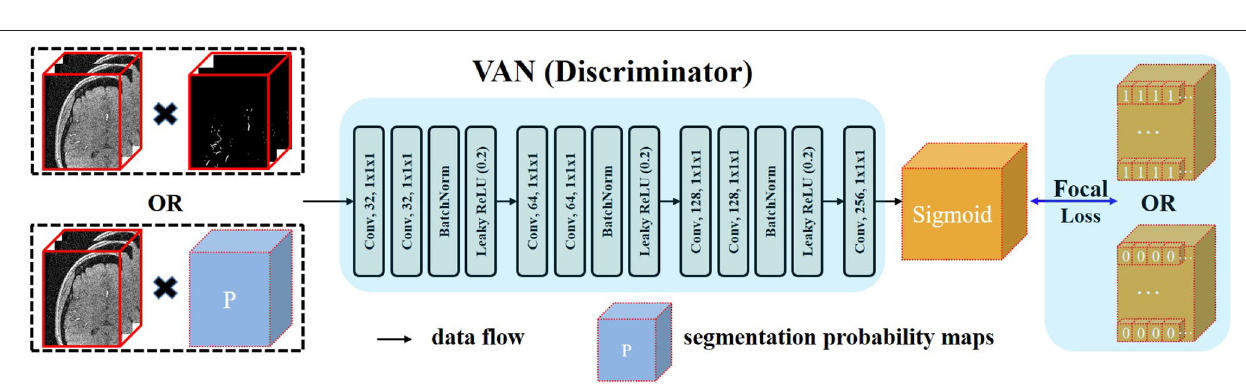
FIGURE 2 | Architecture of the proposed voxel-wise adversarial network (VAN). VAN is trained to distinguish the source of its input. In the context of generative adversarial network (GAN), the procedure of adversarial training is to minimize the discrepancy between two distributions. Since we want voxel-wise similar distribution between the distribution generated by FiboNet and the real data distribution, we input these two types to VAN. Kernel size of 1 is used in VAN. FL is utilized as the loss function to relieve the problem of class